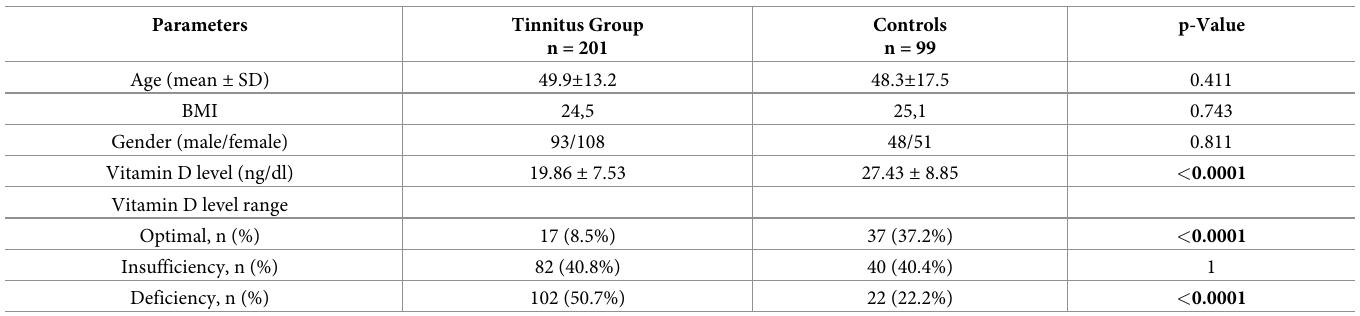
Table 1. Demographic characteristics and 25(OH)D blood level of the tinnitus group and controls.